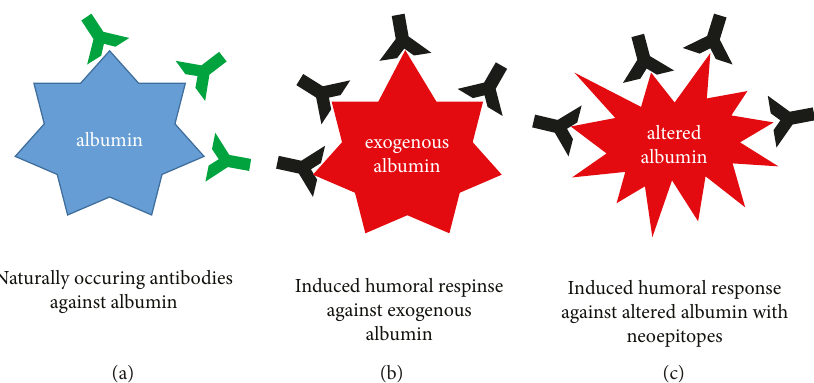
Figure 1: Hypothetical mechanisms promoting antibody formation against albumin. Blue represents the native form of albumin; red represents exogenous albumin or altered forms of native albumin (e.g., oxidized albumin, glycated albumin), both being potentially immunogenic. (a) Naturally occurring antibodies (green Y) may be present in healthy individuals and diseased patients forming immune complexes with albumin. (b) Exogenous albumin may induce a humoral immune response if recognized as foreign antigen. (c) Native albumin might be altered by enzymatic or nonenzymatic processes leading to formation of neoepitopes that are potentially immunogenic. Antialbumin antibodies (black Y) may facilitate the disposal of altered albumin under physiological